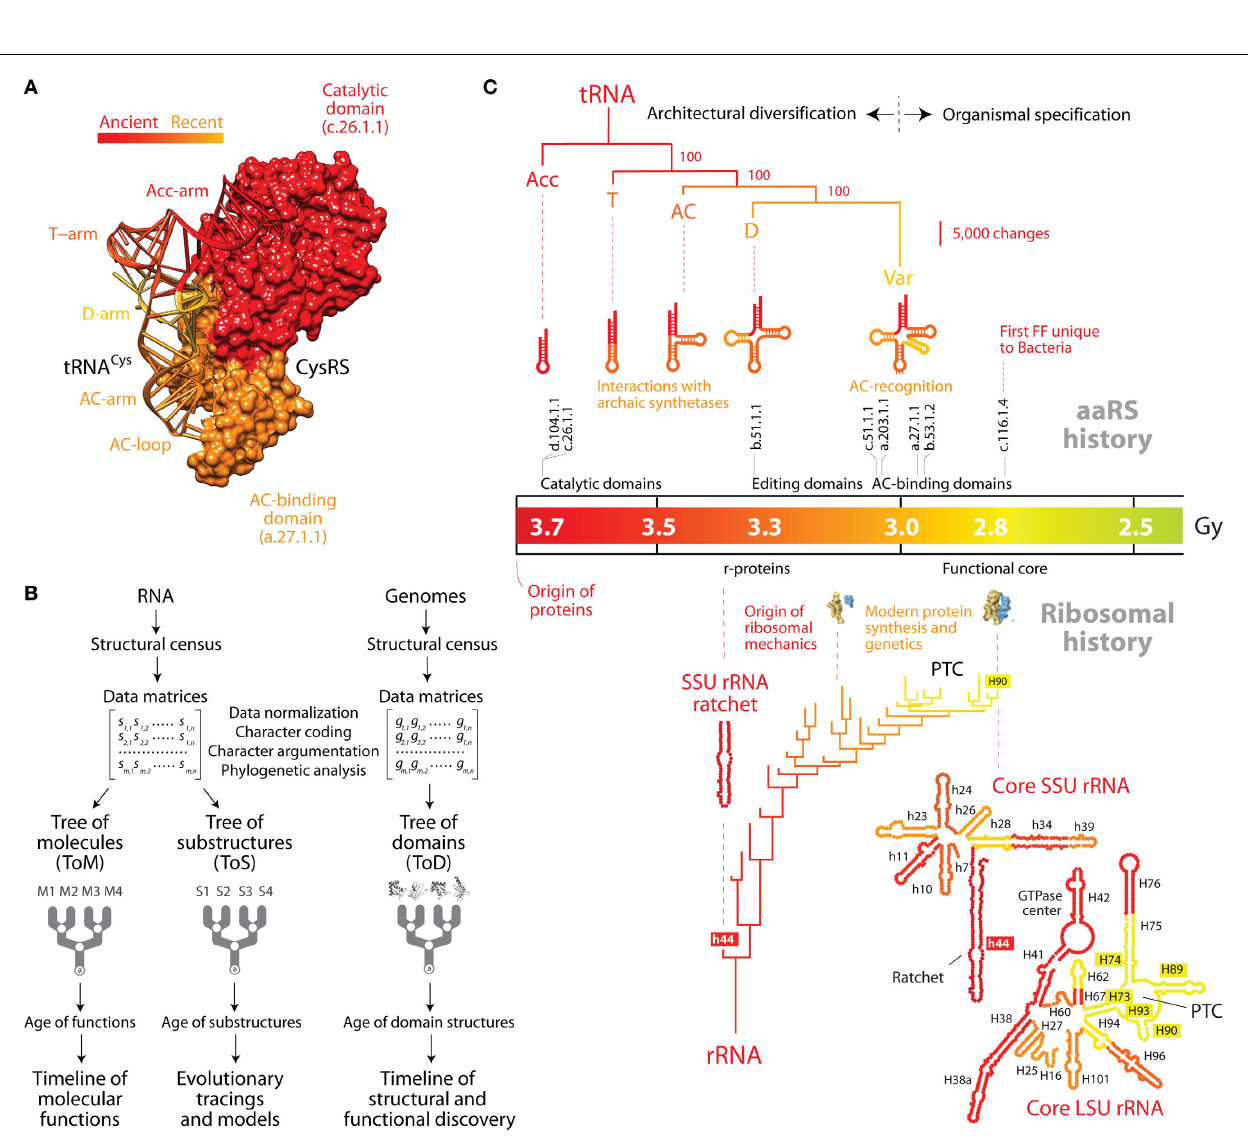
FIGURE 1 | The natural history of tRNA inferred from nucleic acid-protein interactions and structural phylogenomics. (A) The history of tRNA portrays the history of its interactions with cognate aminoacyl-tRNA synthetase (aaRS) protein enzymes. This is exemplified by the domains of the tRNA and cysteinyl-tRNA synthetase binary complex (PDB entry 1U0B), which are colored according to their age. The ancient “top half” of tRNA embeds a “operational code” in the identity elements of the acceptor arm that interact with the catalytic domain of aaRSs through classes I and II modes of tRNA recognition. The evolutionarily recent “bottom half” of tRNA holds the standard code in identity elements of the anticodon loop that interact with anticodon-binding domains of aaRSs. (B) Flow diagram showing the retrodiction strategy used to build phylogenetic trees of RNA molecules (ToMs) and associated trees of substructures (ToSs), and trees of protein domains (ToDs). The structures of RNA molecules are first decomposed into substructures. Structural features of substructures such as helical stem tracts and unpaired regions are coded as phylogenetic characters and assigned character states according to an evolutionary model that polarizes character transformation toward an increase in conformational order (character argumentation). Coded characters (s) are arranged in data matrices, which can be transposed. Phylogenetic analysis using maximum parsimony optimality criteria generates rooted ToMs and ToSs. A census of domain structures in proteomes of hundreds